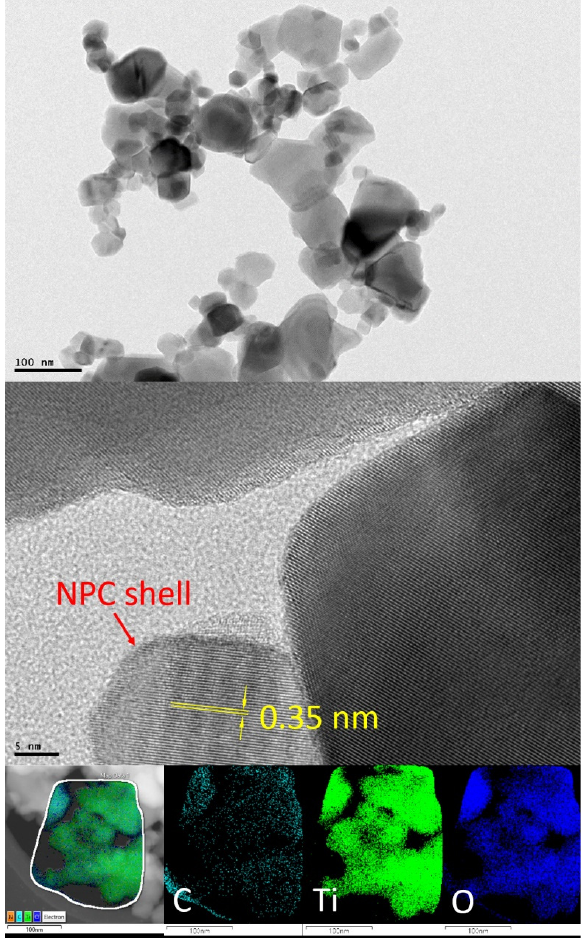
Figure 1. TEM image of NPC-TiO 2 1 ( up ); HRTEM image of NPC-TiO 2 1 ( middle ); HAADF-STEM- EDS image of NPC-TiO 2 nanohybrid 1 ( bottom-left ). The images for the EDS elemental mapping for elements C, Ti and O: bottom-left image display all elements mapping at a time, while the rest of images display the individual elemental maps.